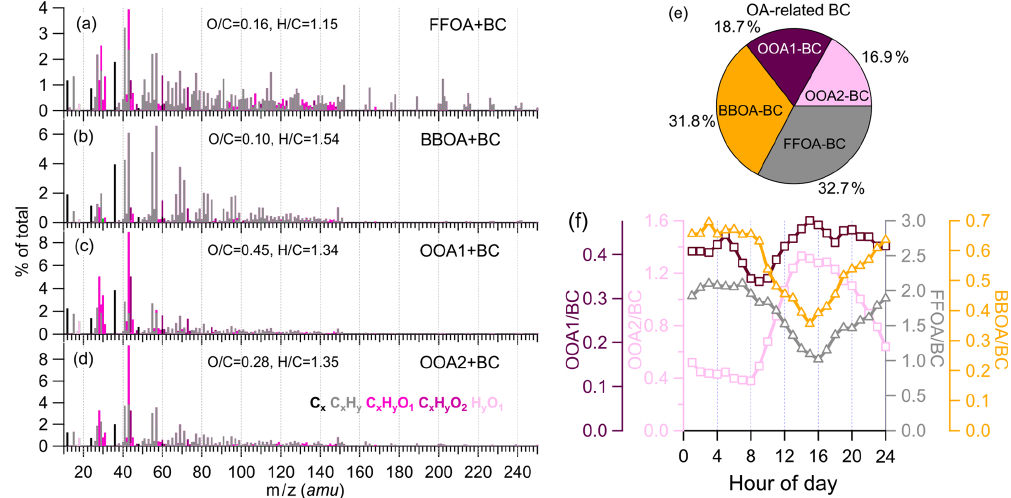
Figure 4. High-resolution mass spectra of (a) fossil fuel combustion OA (FFOA + BC), (b) biomass-burning OA (BBOA + BC), (c) OOA1 + BC, (d) OOA2 + BC, (e) mass fractions of the BC fragments apportioned in different OA factors, and (f) diurnal cycles of the four OA factors relative to